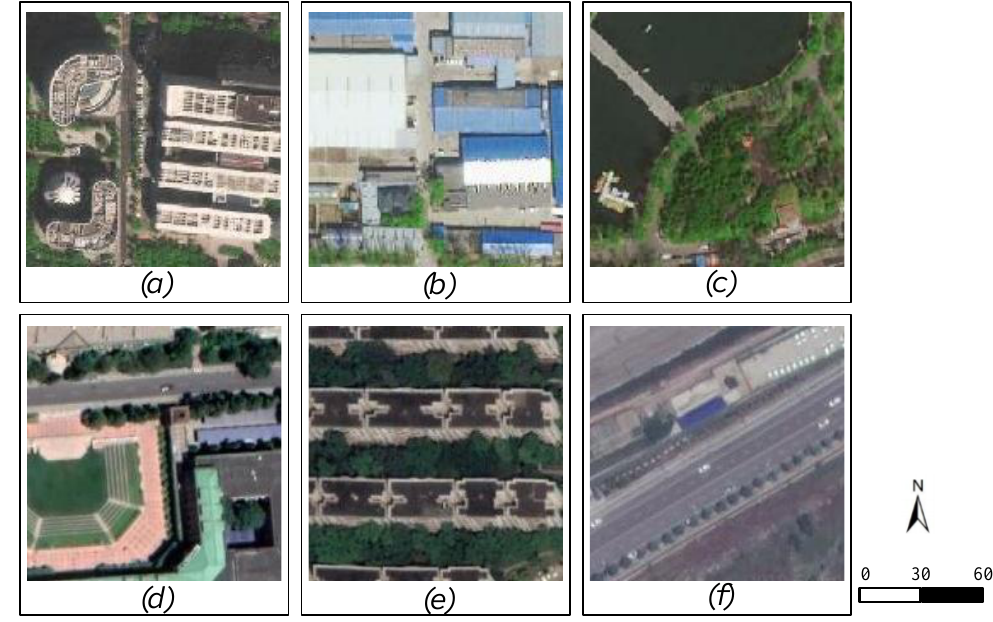
Figure 1. The remote sensing images of different urban functional regions. ( a ) Commercial and business facility, ( b ) Industrial area, ( c ) Green space and square, ( d ) Administration and public service, ( e ) Residence, ( f ) Transportation zone.